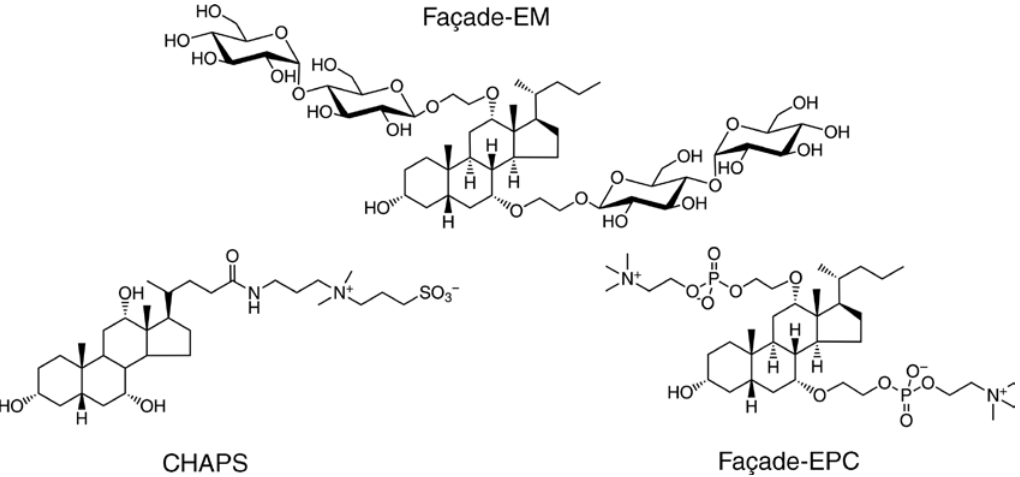
Figure 1: Structures of bicelle rim-forming agents, used in the current study: CHAPS, Façade-EPC, and